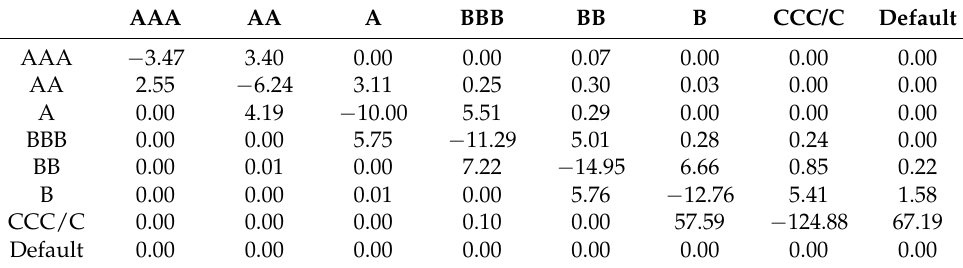
Table 3. The applied generator matrix